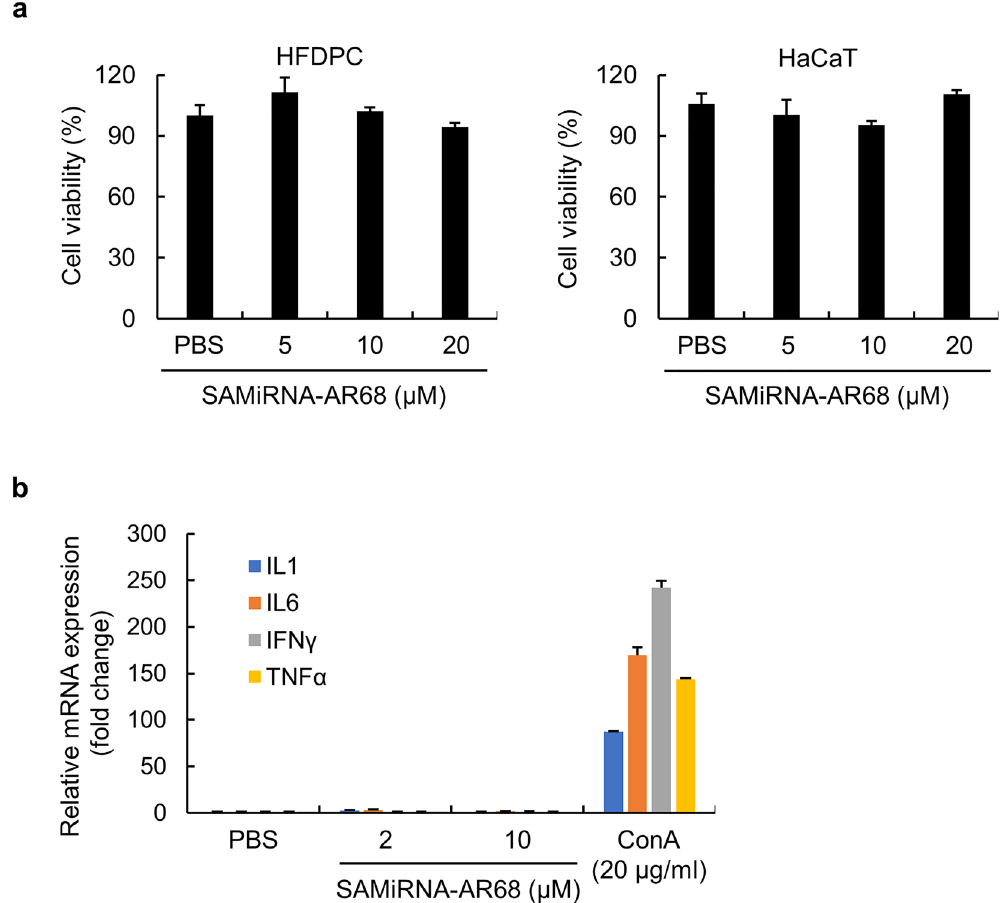
Figure 4. The safety of SAMiRNA-AR68. ( a ) HFDP and HaCaT cells were treated with PBS or the indicated dose of SAMiRNA-AR68 for 72 h. WST-1 assays were performed to measure cell viability. ( b ) Human PBMCs were treated with 20 μg/ml concanavalin A (ConA) as a positive control, PBS, or the indicated doses of SAMiRNA-AR68 for 6 h. Total RNA extracts were subjected to qPCR assays to evaluate the expression of proinflammatory cytokines, including IL-1β, IL-6, INF-γ and TNF-α, normalized to that of the ribosomal protein L13A (RPL13A) gene.